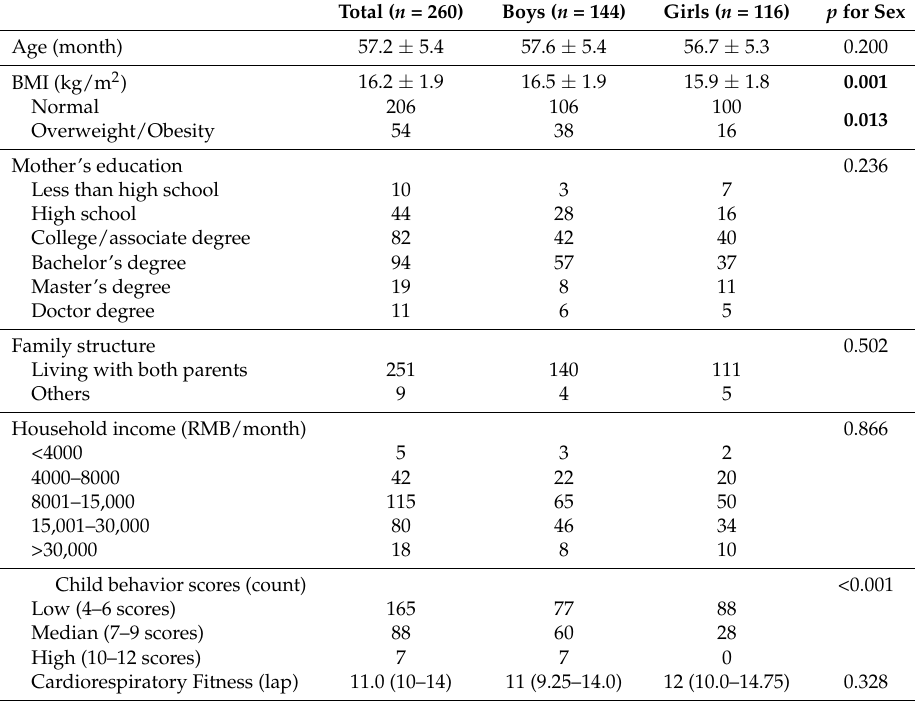
Table 1. Characteristics of the analyzed